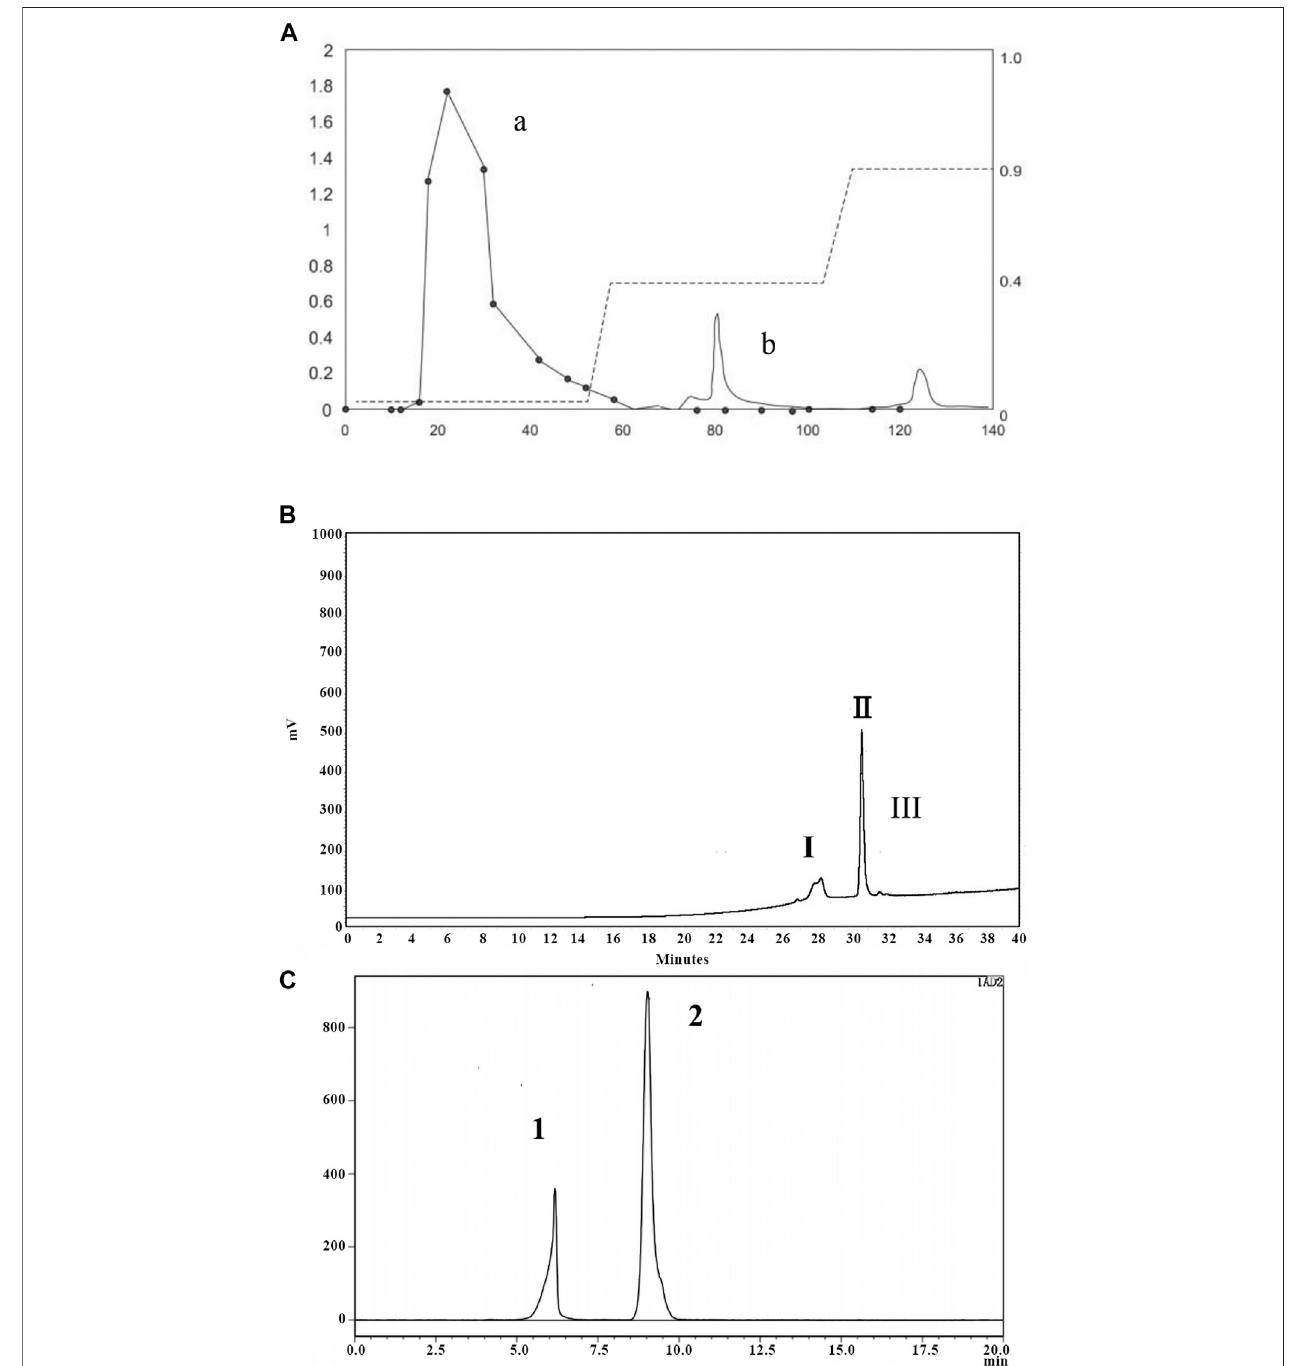
FIGURE 1 | Isolation and puri fi cation chromatogram of PNO. (A) DEAE column chromatography of PNO. (a) Elution curve of sugars obtained using a phenol- sulfuric acid extraction method, with detection conducted via absorbance measurements at 490 nm; (b) protein elution curve determined from absorbance measurements at 280 nm. (B) Separation curve obtained using a Click Xion column via HPLC. (C) Gel chromatography conducted using an OHpak SB-802.5 HQ column via HPLC.